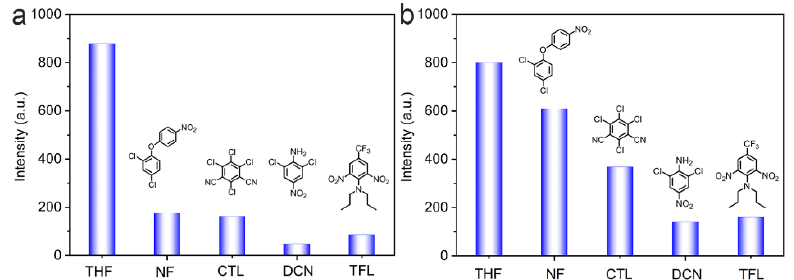
Figure 4. Comparison graphs of the fluorescence intensity for LNU-45 ( a ) and LNU-47 ( b ) in THF solution interacting with different pesticides.